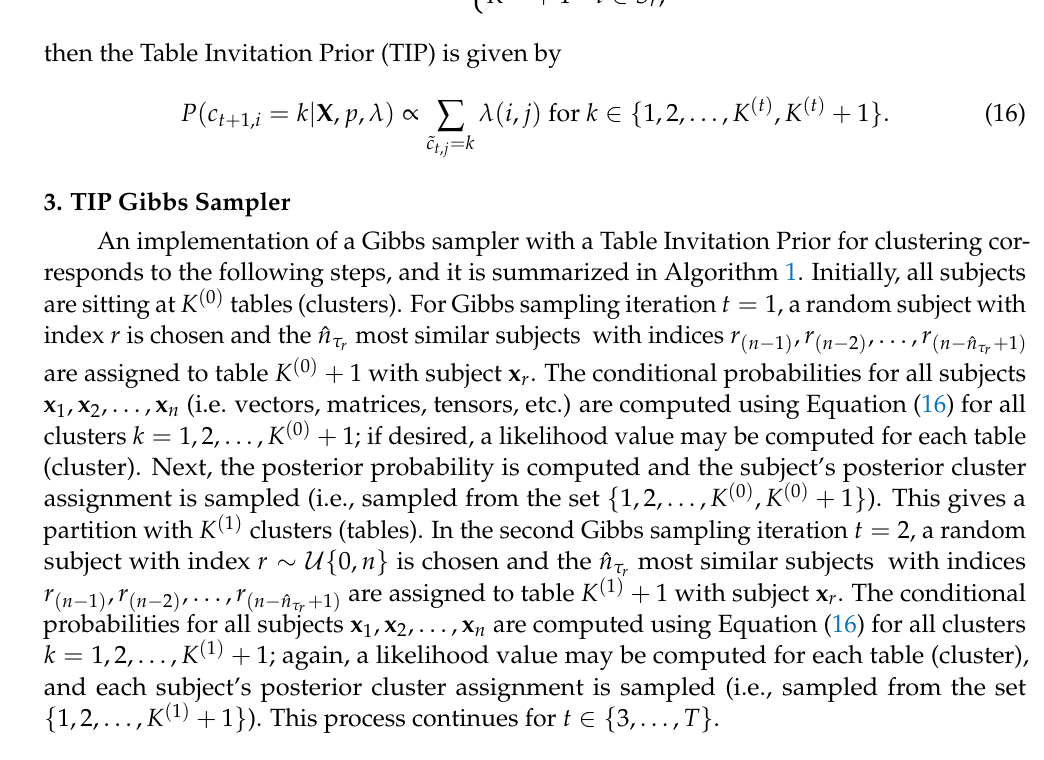
Algorithm 1: Table Invitation Prior